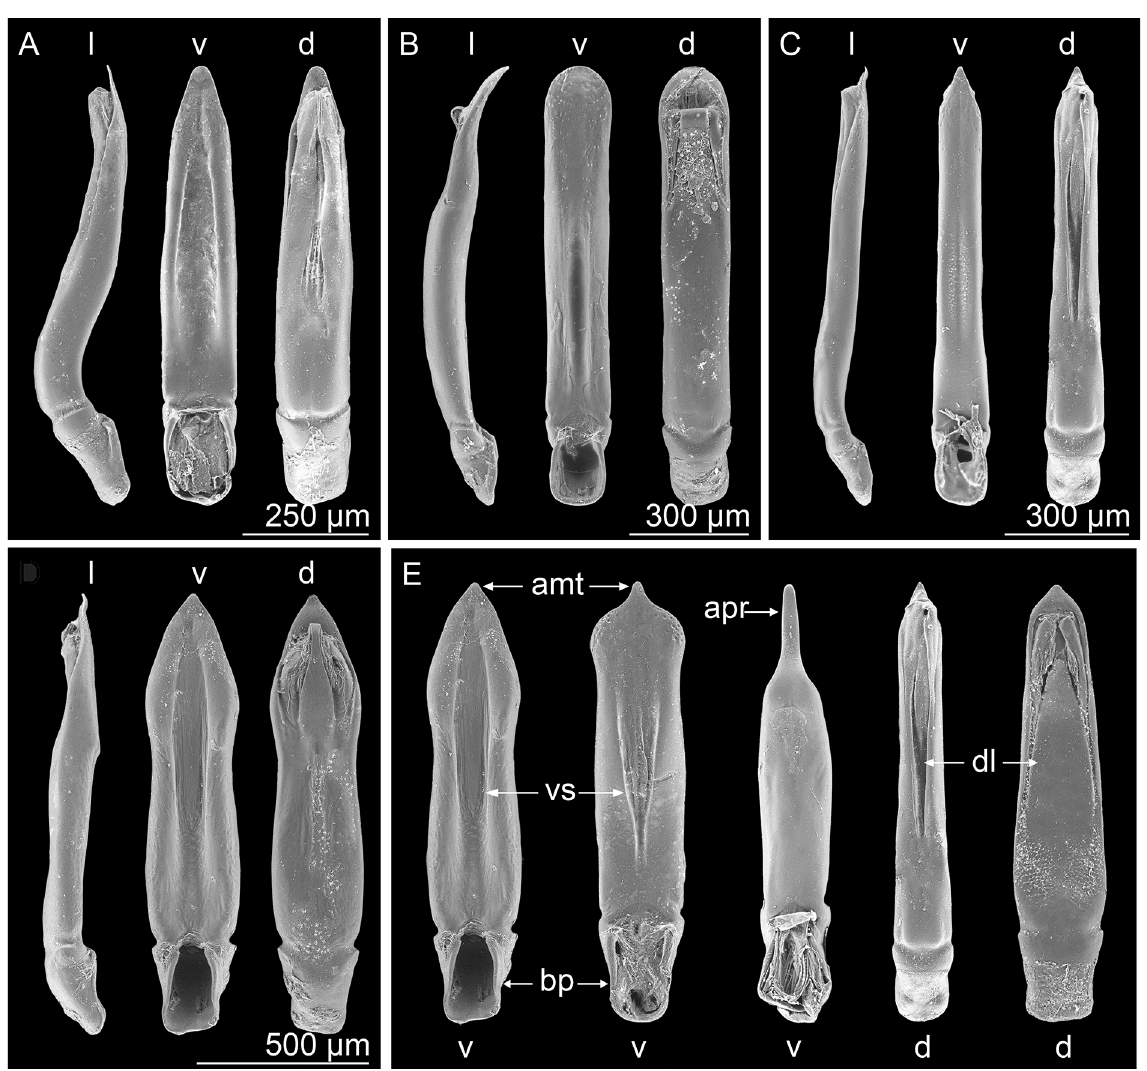
Fig. 10. Median lobe of aedeagus in lateral (l), ventral (v) and dorsal (d) view. A . Arsipoda